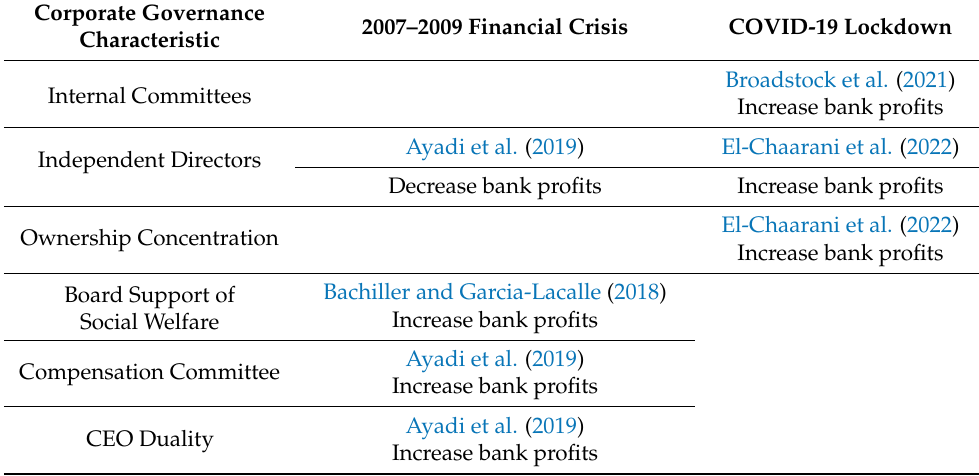
Table 1. Summary of the Literature on Corporate Governance on Bank Performance During